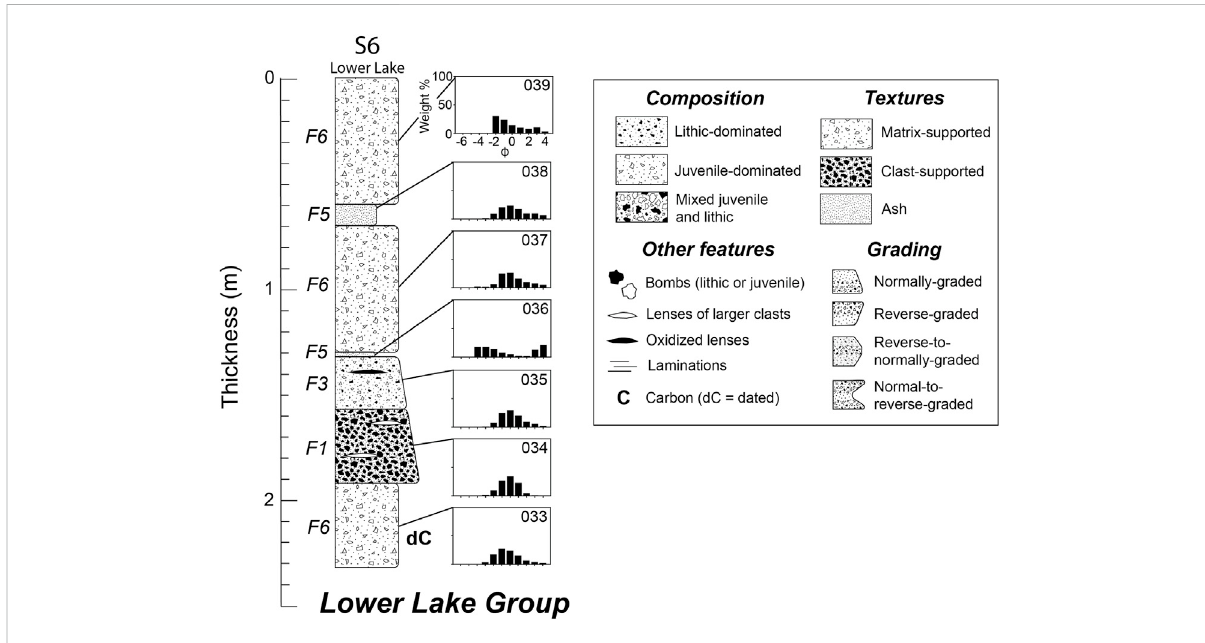
FIGURE 8 Stratigraphy of an outcrop at the southeast end of Clear Lake, just east of Thurston Lake. See Figure 5 caption for interpretation notes; no correlations or relationships to source vents are